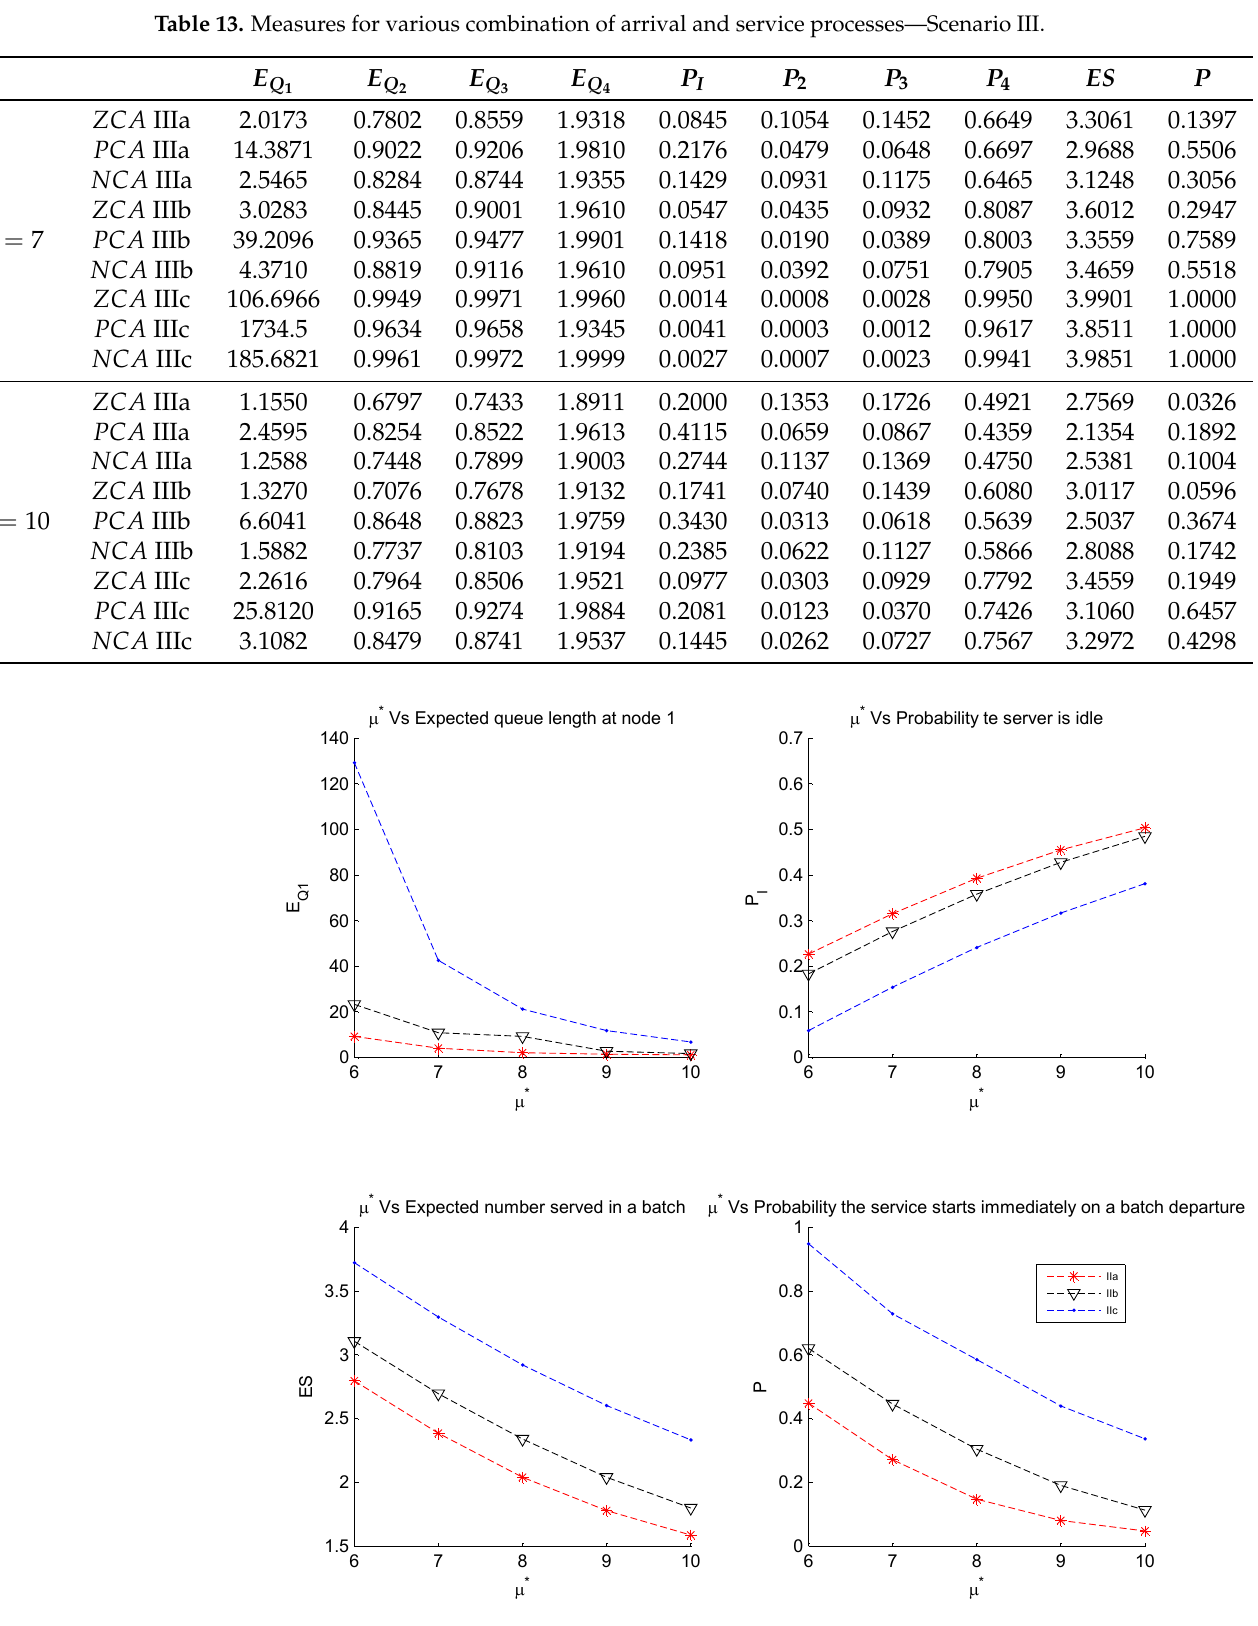
Figure 2. Effect of weighted average service rate on system characteristics in Scenario